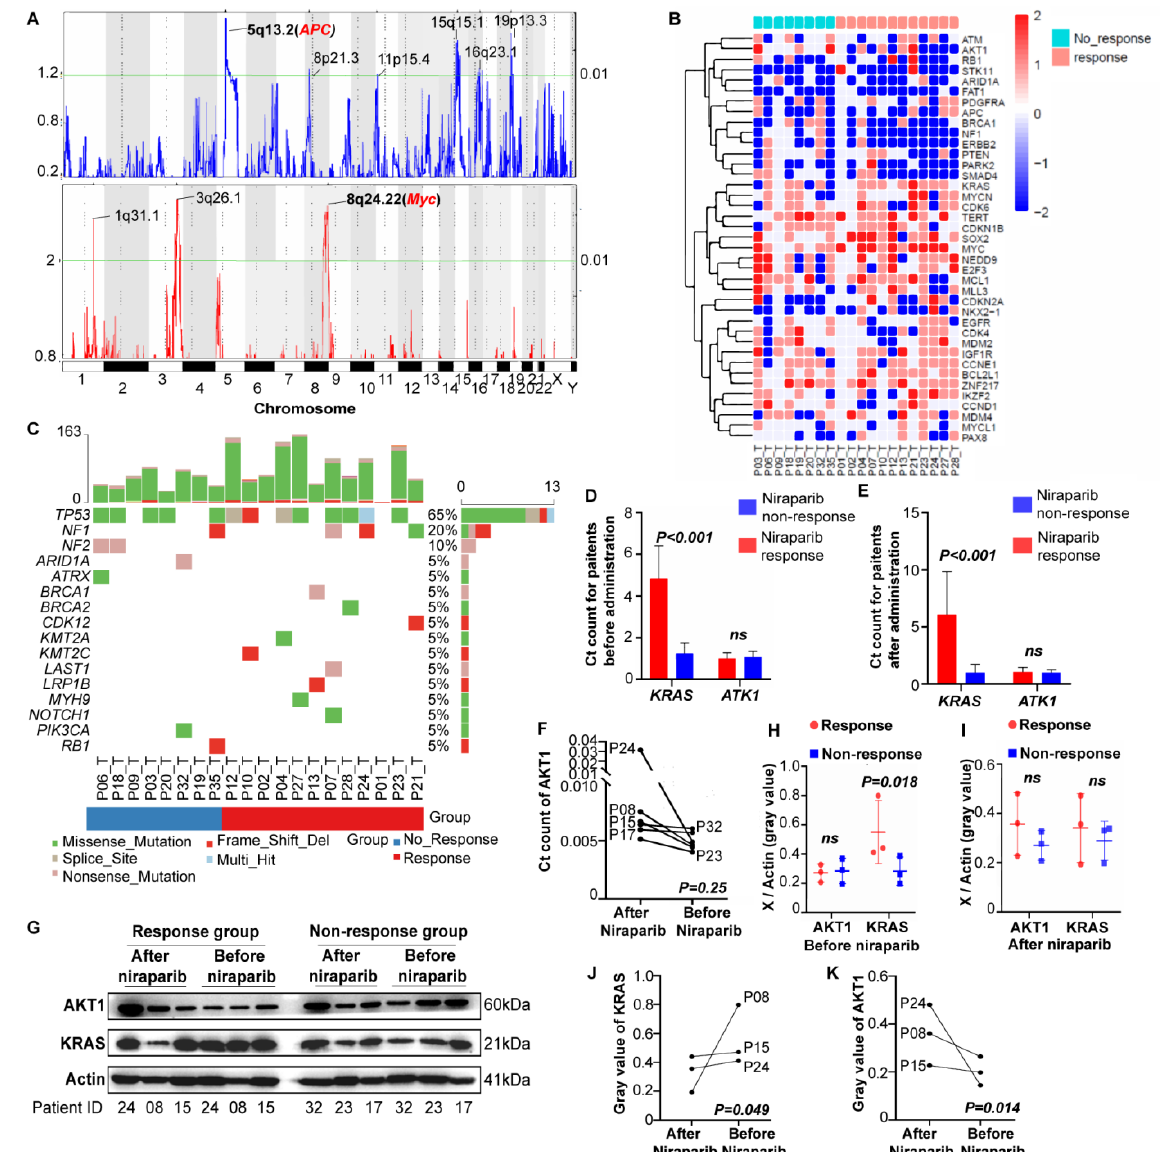
Figure 2. Finding novel molecular biomarkers of PARPis. ( A ) The copy number variations (CNVs) in the olaparib and niraparib response groups. The bottom of the figure indicates the chromosome, the left number is the GISTIC Gscore (CNV frequency multiplied by CNV amplitude), and the right number is the q-value. The upper figure shows gene deletions (blue), and the lower figure shows gene enrichments (red). The detailed loci of any statistically significant CNVs ( p < 0.01) are labeled. ( B ) The cluster analysis of CNVs in the responder and nonresponder groups. ( C ) Driver mutation analysis in the responder and nonresponder groups. The RNA ( D – F ) and protein ( G – K ) levels of KRAS and AKT1 were measured in the PDX tumor tissue before and after niraparib administration in the responder and nonresponder groups (three in each). Differences in KRAS and AKT1 RNA levels between the responder and nonresponder groups before ( A ) and after ( B ) niraparib treatment. ( C ) Changes in AKT1 RNA levels before and after niraparib treatment in the same patient. (D) The immunoblotting result, followed by the analysis of its gray values. Differences in KRas and Akt1 protein levels between the responder and nonresponder groups before ( E ) and after ( F ) niraparib treatment. Changes in Akt1 ( G ) and KRas ( H ) levels before and after niraparib treatment in the same patient from the responder group.